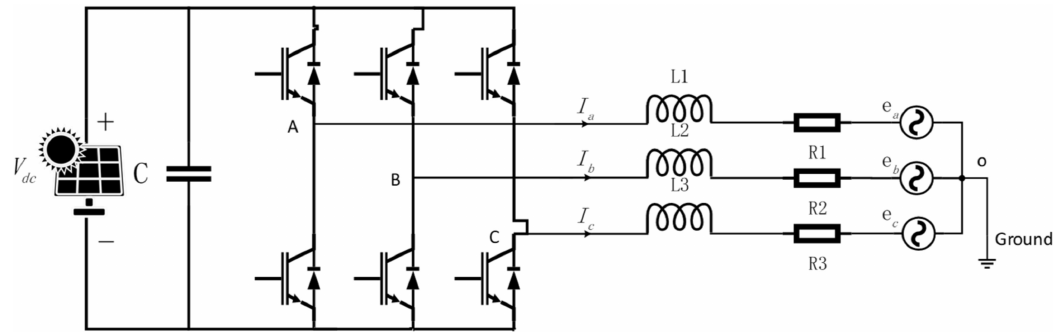
Figure 1. Model of the grid connected PV